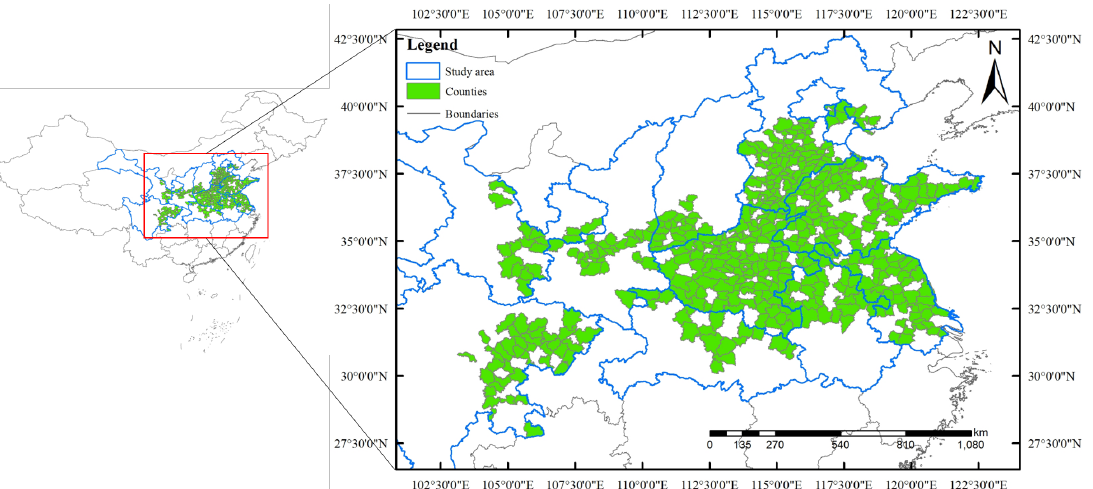
Figure 1. The study area which is the main winter wheat producing areas in